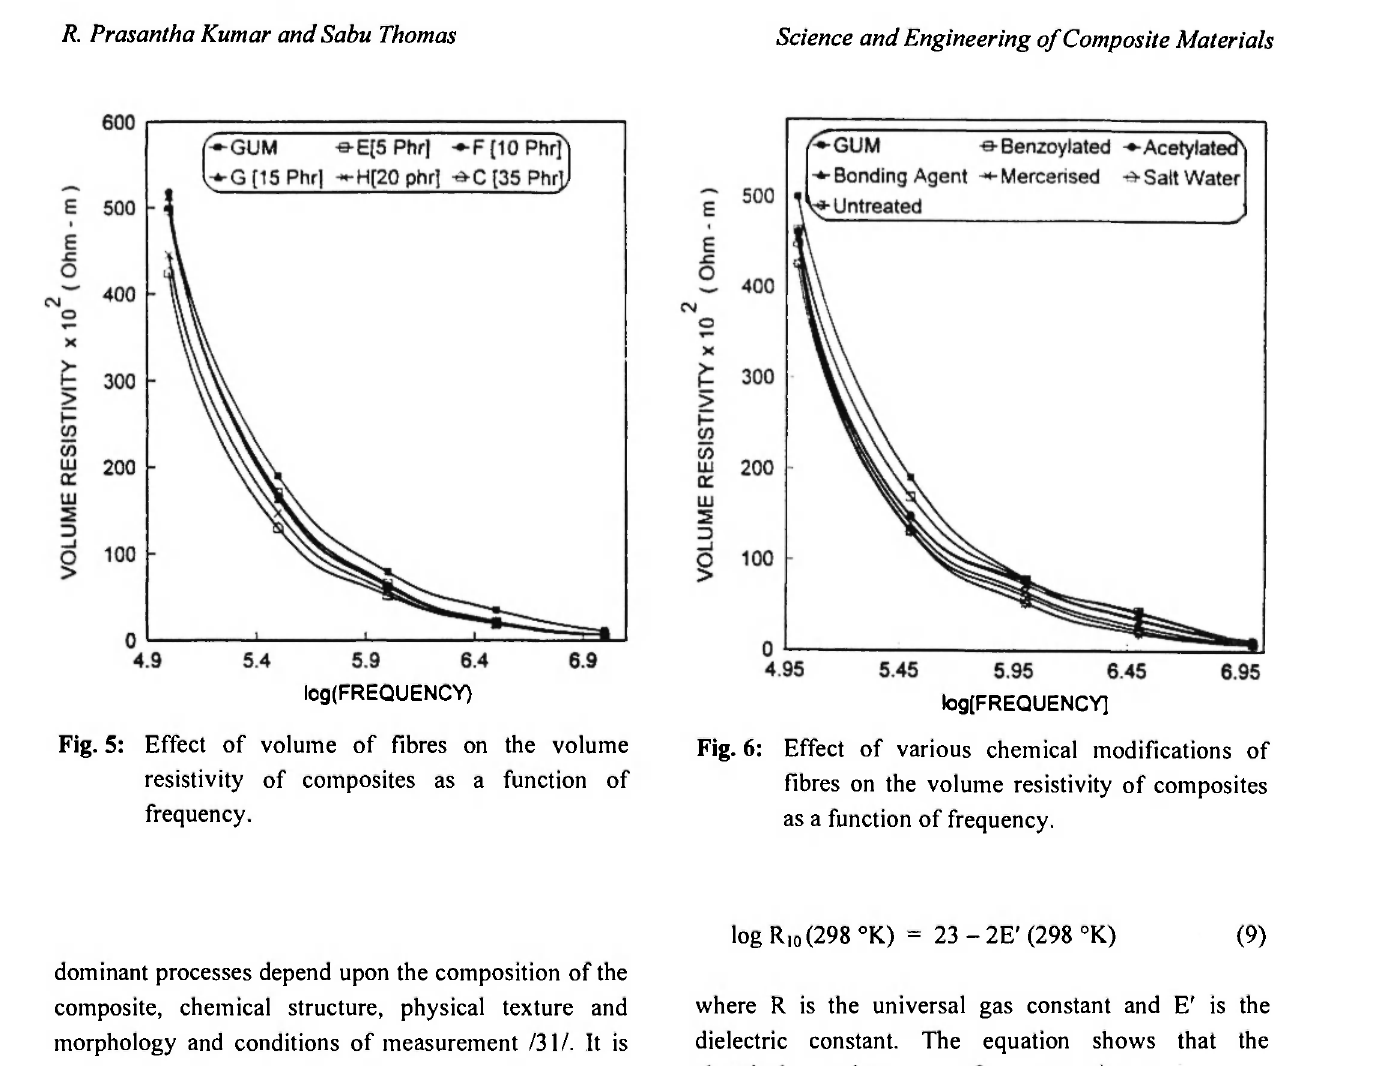
Fig. 5: Effect of volume of fibres on the volume resistivity of composites as a function of frequency.